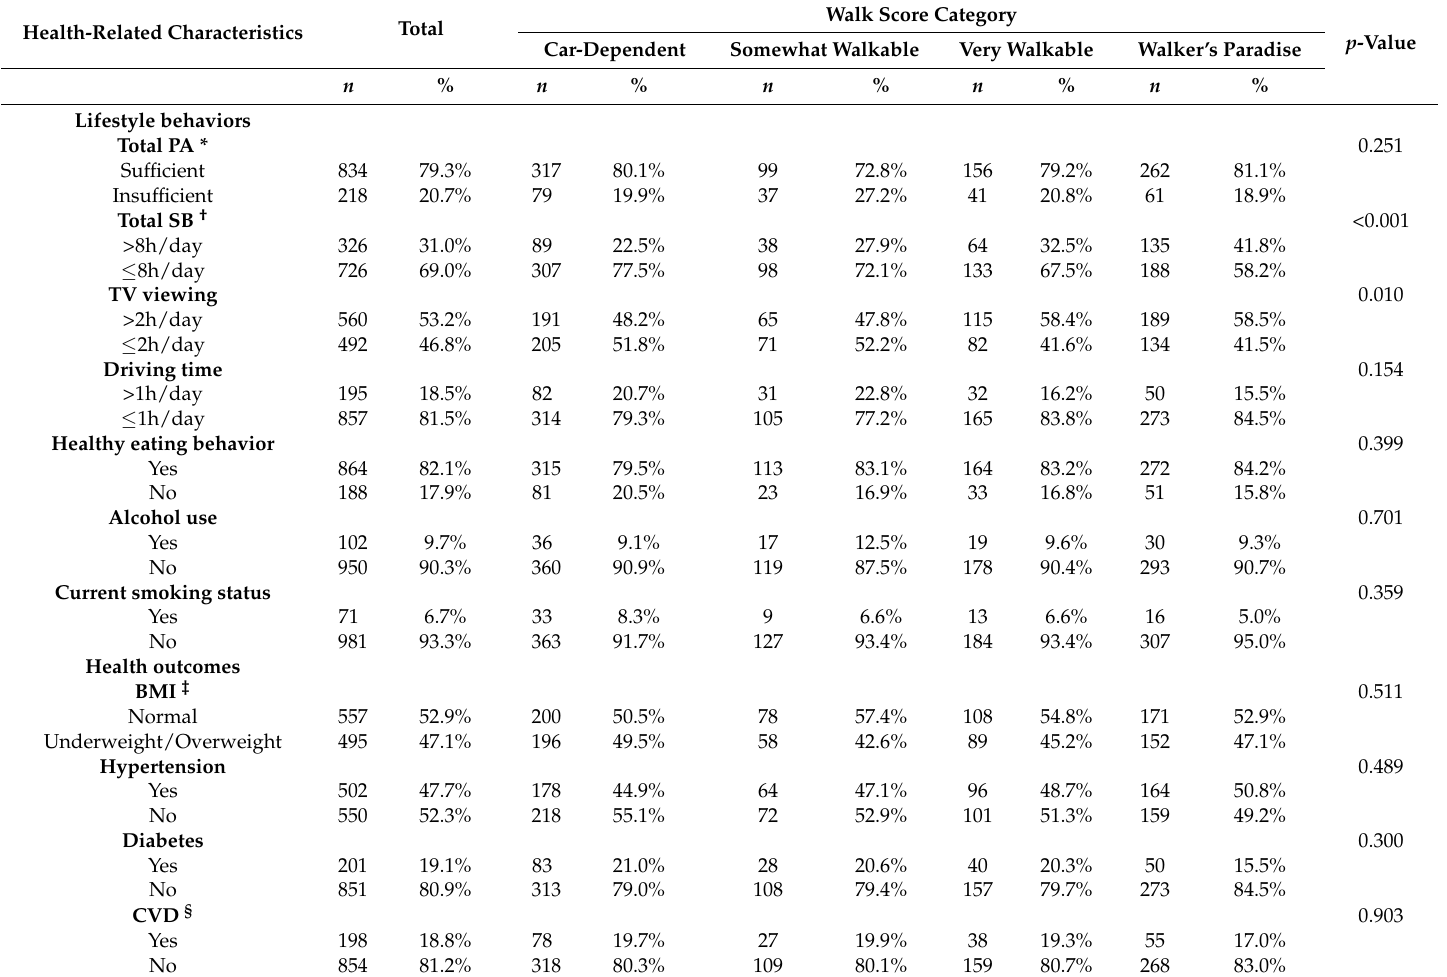
Table 2. Participants’ health lifestyle behaviors and outcomes by walk score category (n =